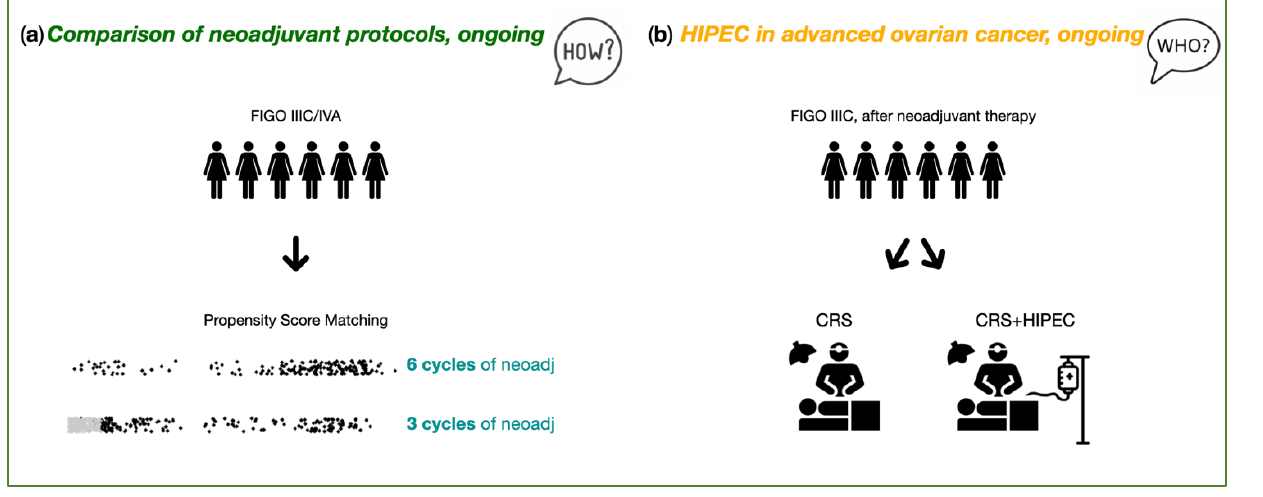
Figure 5. Italian PSM Oncoteam study purposes. ( a ) Marrelli et al. “OVANAC–HIPEC”. ( b ) Ansaloni et al. “CHORINE”. FIGO: International Federation of Gynecology and Obstetrics, neoadj: neoadjuvant therapy, CRS: cytoreductive surgery, HIPEC: hyperthermic intraperitoneal chemother-